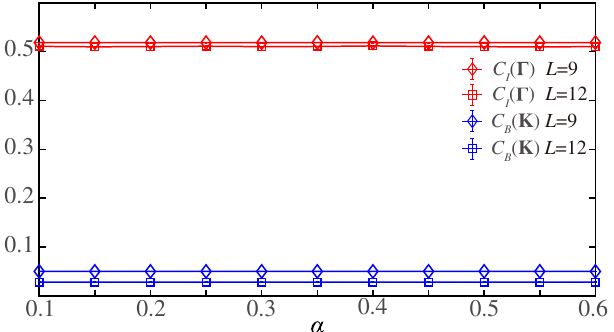
FIG. 5. C I ð Γ Þ and C B ð K Þ as a function of α at the strong- coupling limit. We perform the QMC simulation with projection length Θ ¼ 200 L , interval of time slice Δ τ ¼ 0 . 1 , and spatial system sizes L ¼ 9 , 12, and by setting U ¼ 1 as a dimensionless constant. The corresponding correlation function C I ð Γ Þ of IVC is close to the saturation value of 0.5, and the correlation function C K Þ of the cVBS is close to 0, which means the cVBS B ð disappears at the strong-coupling limit.